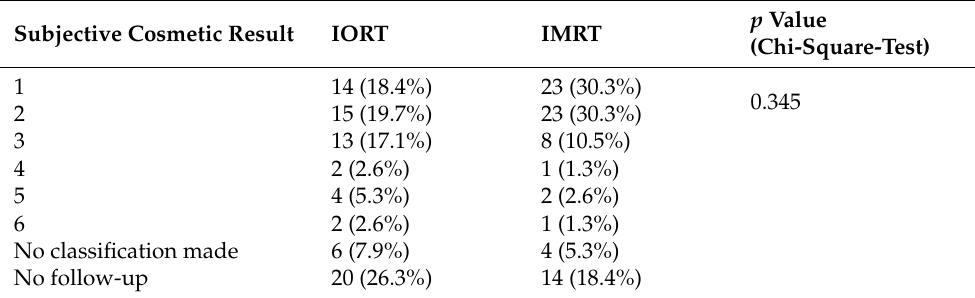
Table 6. Subjective cosmetic result evaluated during follow-up, scale equal to school grades (1: very good, 6: poor).